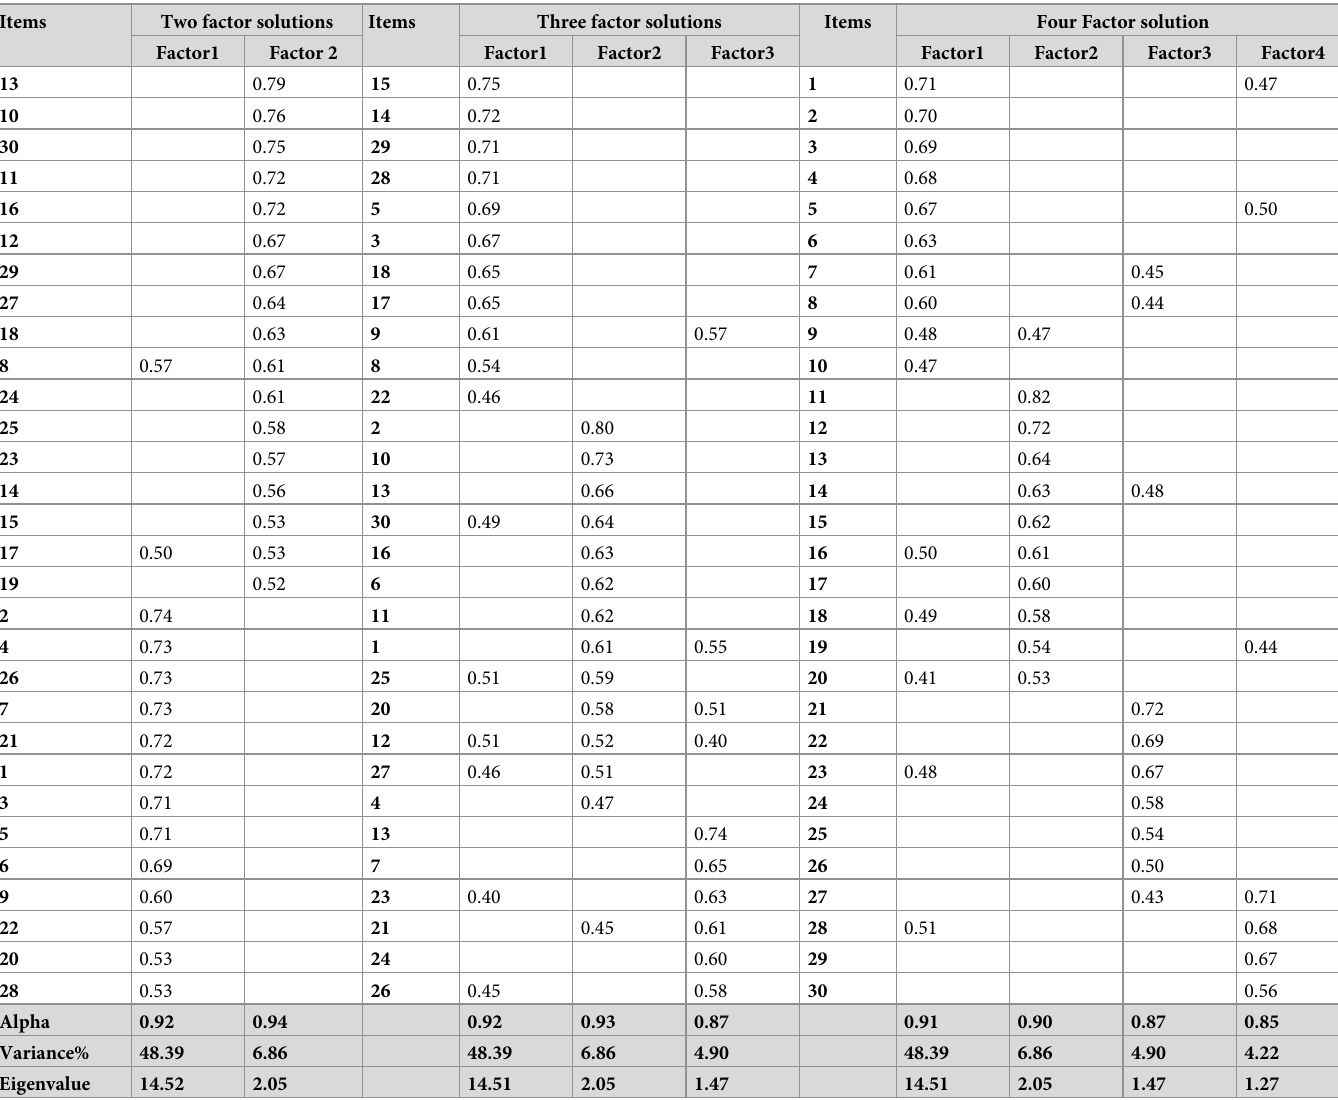
Table 2. EFA of the PBQ; comparing three different factor